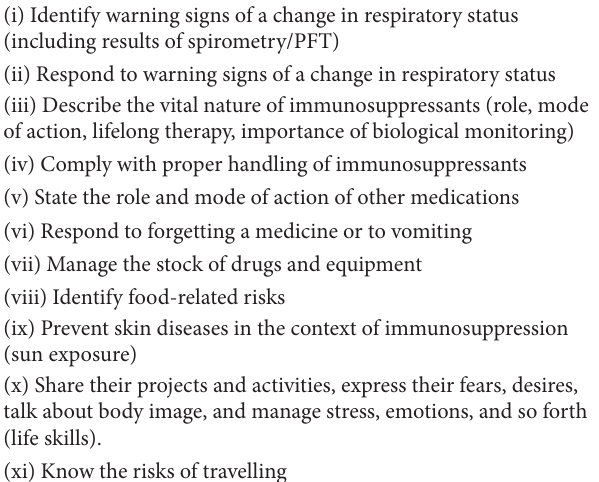
Table 6: Learning objectives for the time between LTX and first return